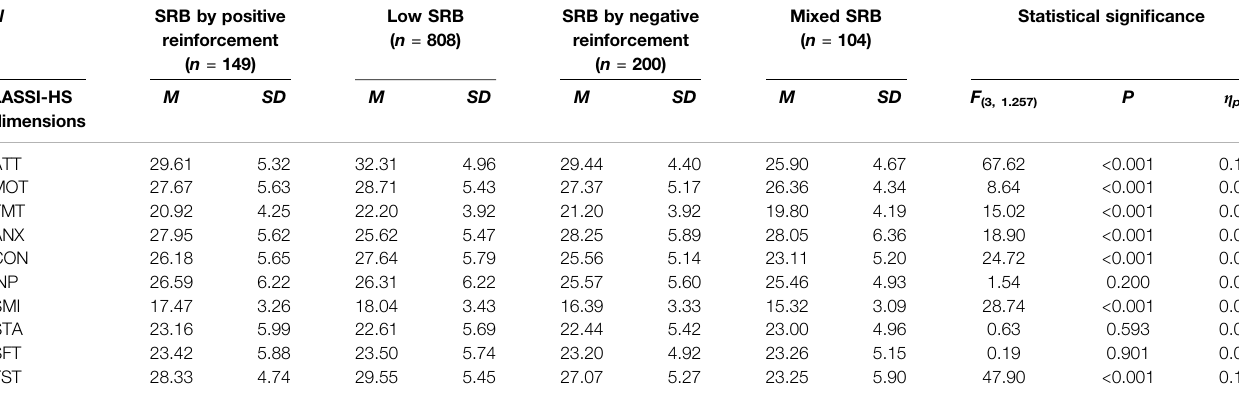
TABLE 2 | Means and standard deviations obtained by the four pro fi les of school refusal behaviour in LASSI-HS dimensions